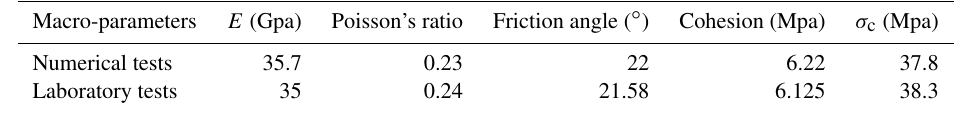
Table 3. Comparison of macro-properties determined by numerical and laboratory tests.